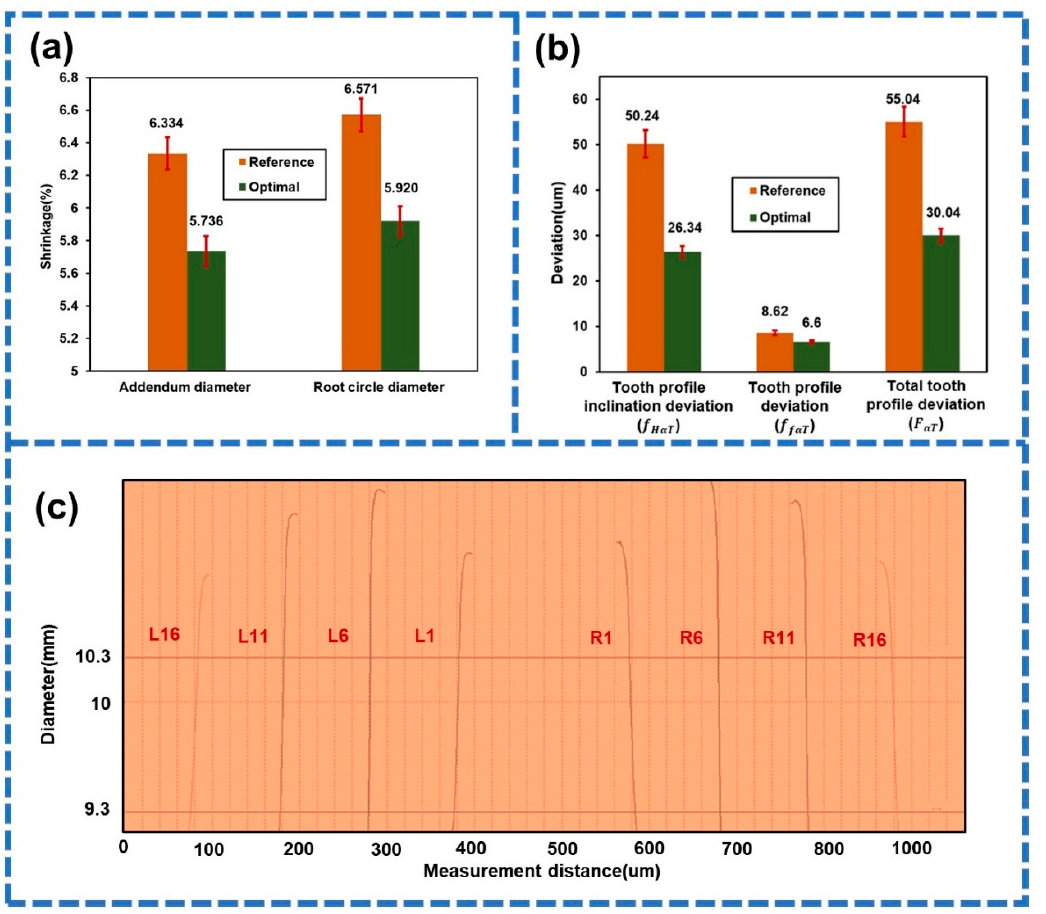
Figure 13. ( a ) Key dimensions’ shrinkage in the experiment under optimal process parameters. ( b ) Optimization results of tooth profile accuracy. ( c ) Tooth profile deviation curve of gear sample with the highest tooth profile accuracy under optimal parameters.